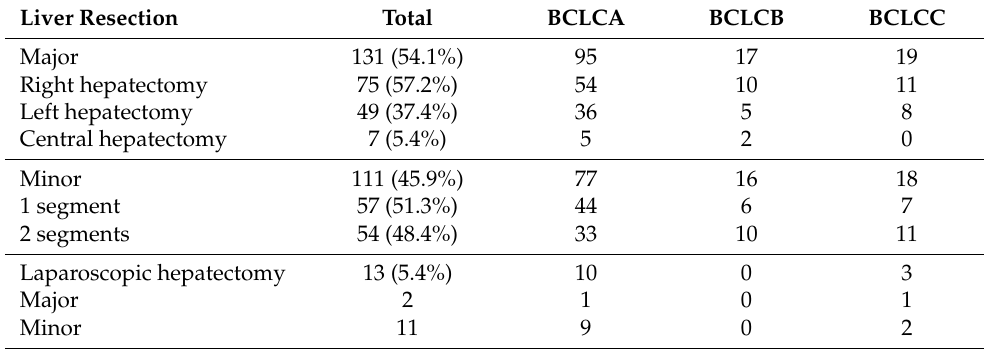
Table 2. Type of resection.